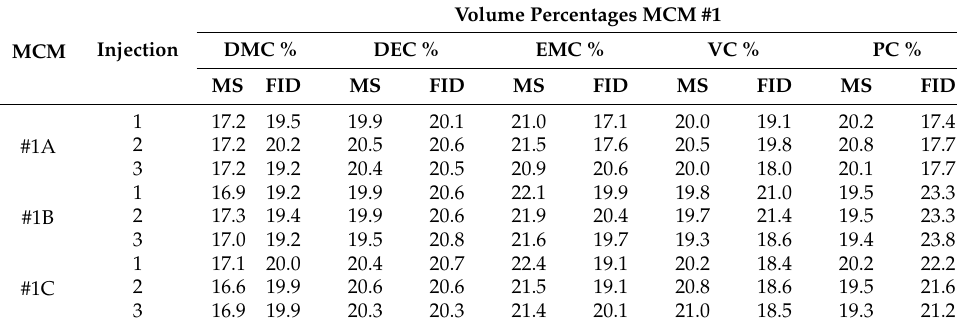
Table 7. Volume fraction of the components in MCM #1A-C measured using GC × GC/FID and